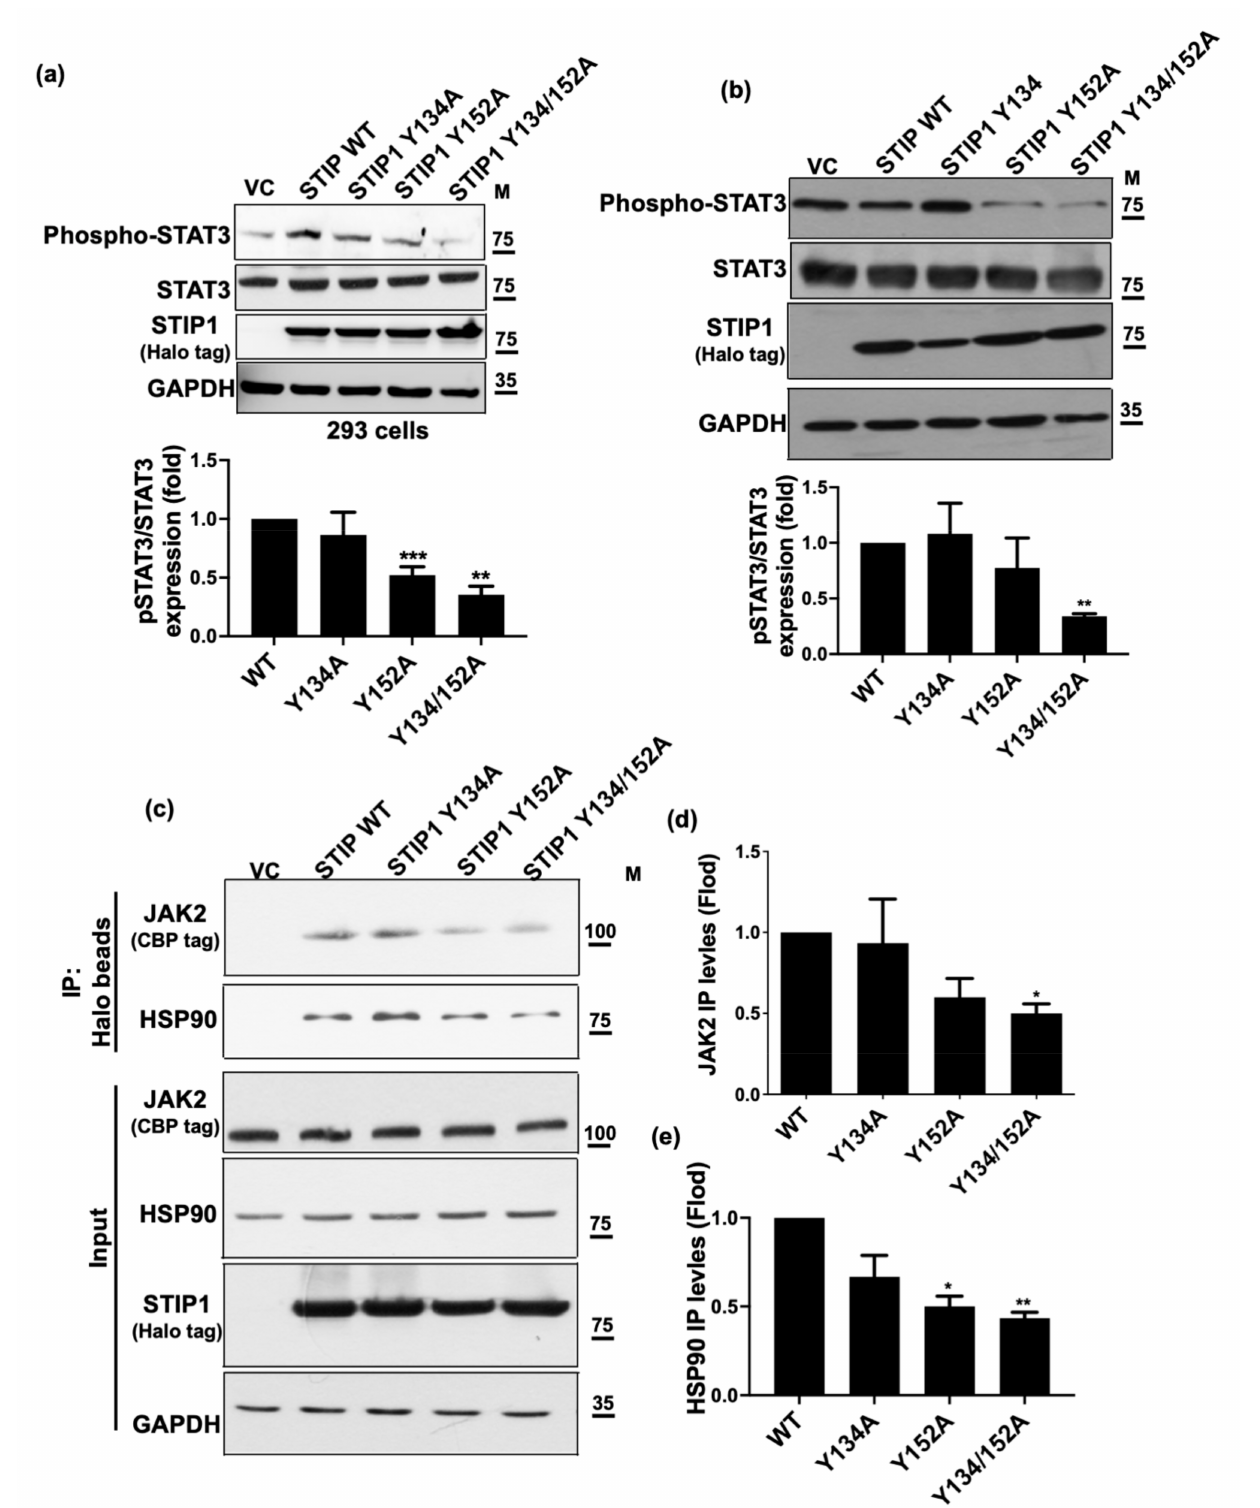
Figure 2. Phosphorylated STIP1 is essential for maintaining the JAK2/STAT3 signaling pathway. Halo-tag of wild-type STIP1 and three different tyrosine phospho-acceptor sites STIP1 mutants (Y134A, Y152A, and the Y134/152A double mutant) were transfected using expression vectors into ( a ) HEK293 cells and ( b ) SKOV3 cells for 48 h. Expression levels of endogenous phospho-STAT3